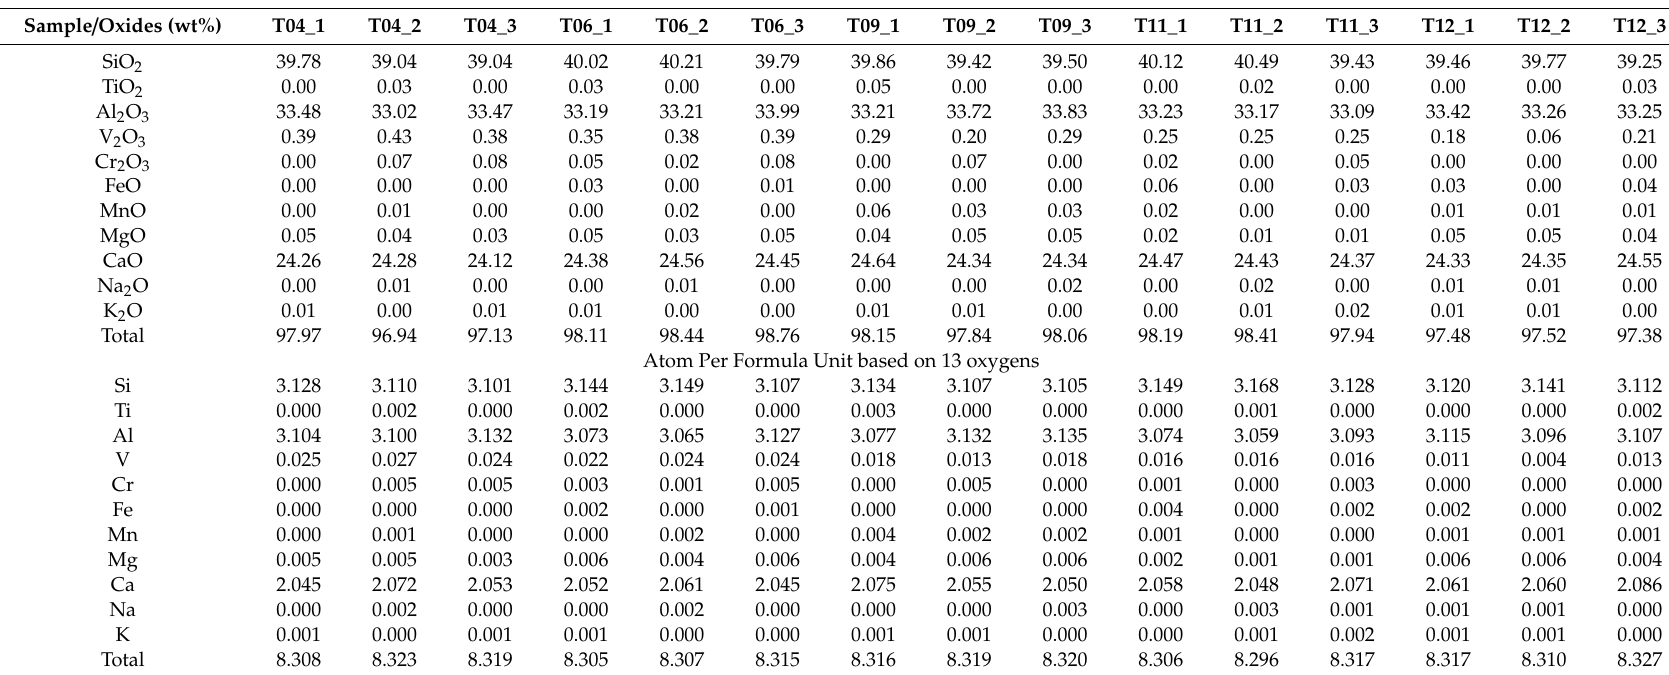
Table 2. Electron probe microanalyzer (EPMA) analyses of major and trace compositions of tanzanite samples under this investigation. Sample / Oxides